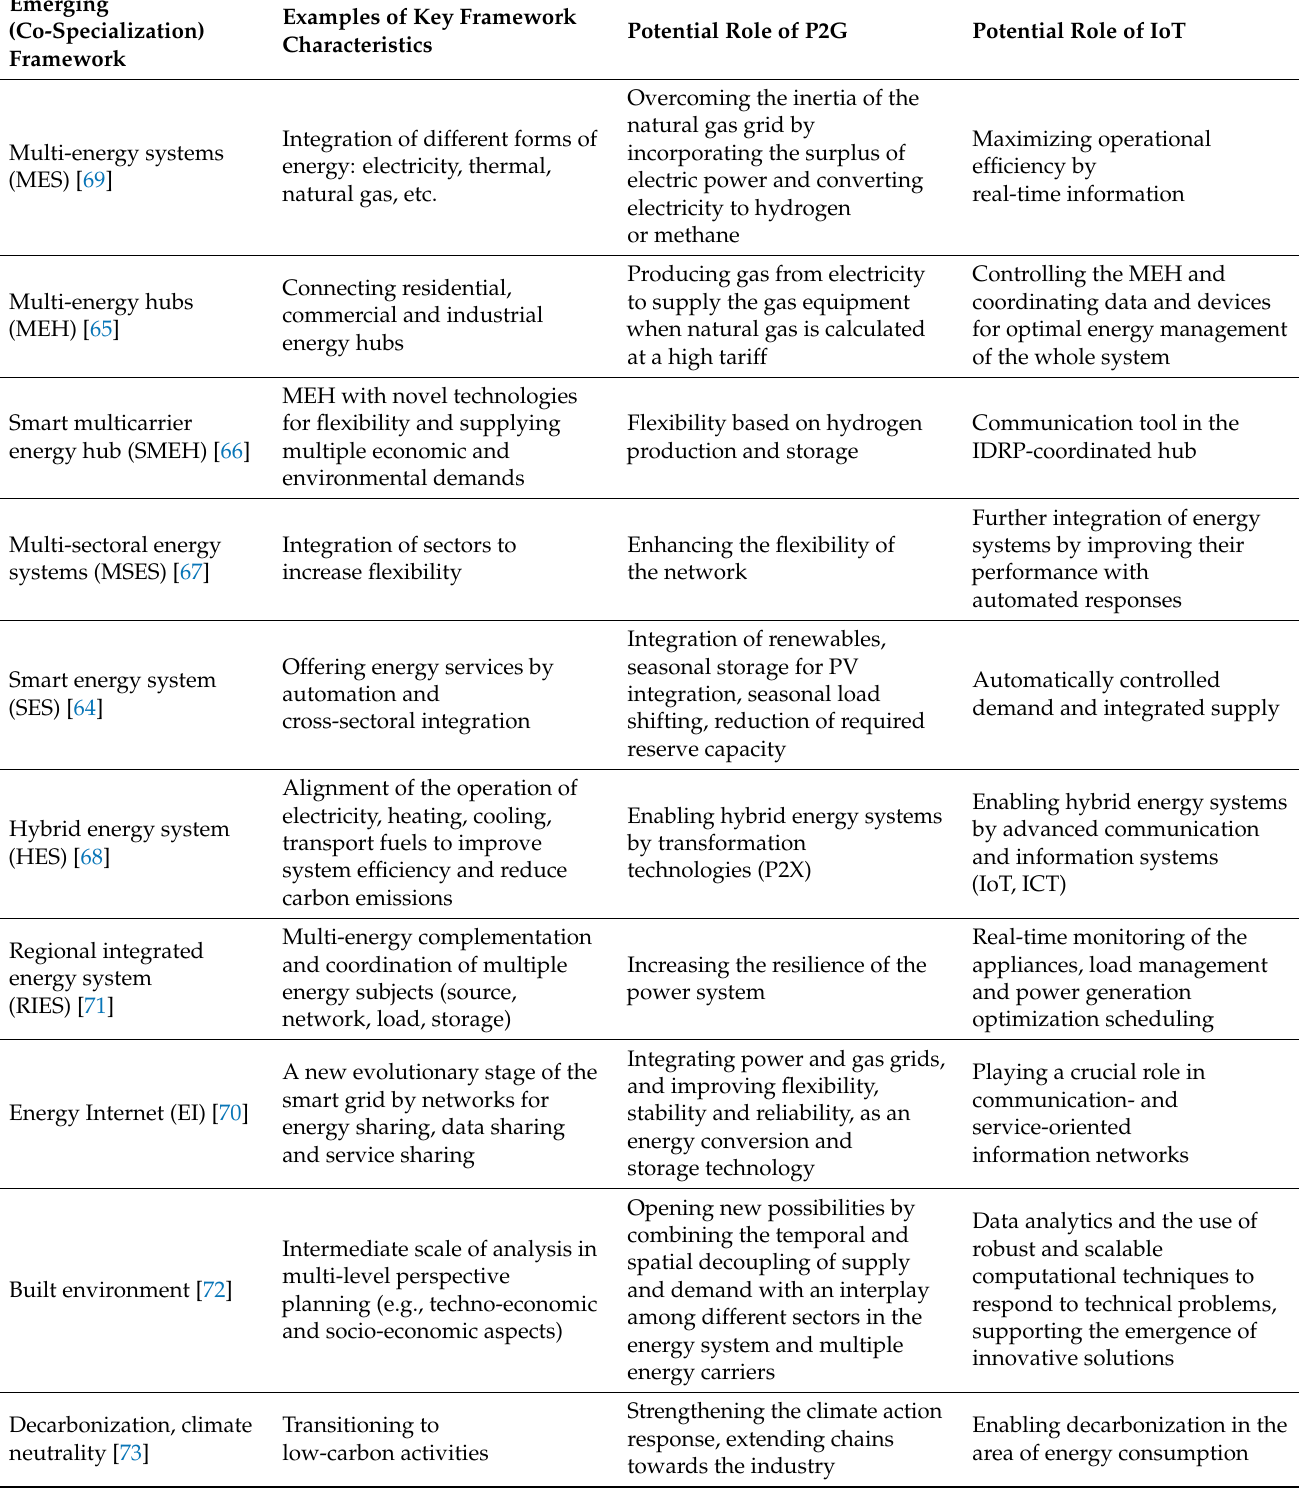
Table 3. Emerging frameworks and roles of P2G and IoT in the